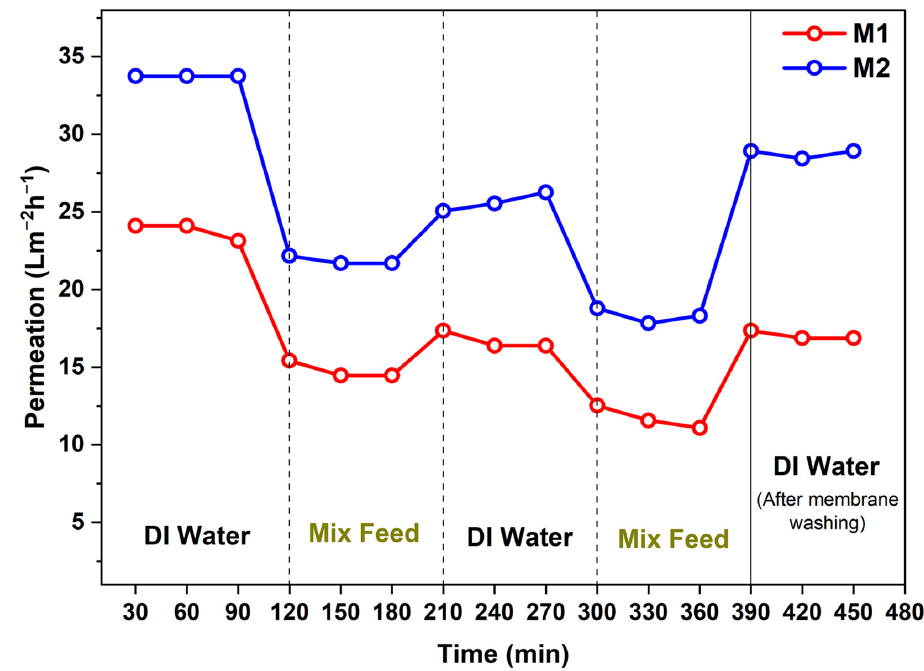
Figure 11. Effect on the permeation of membranes after exposure to fouling materials (in mix feed) for 480 min.